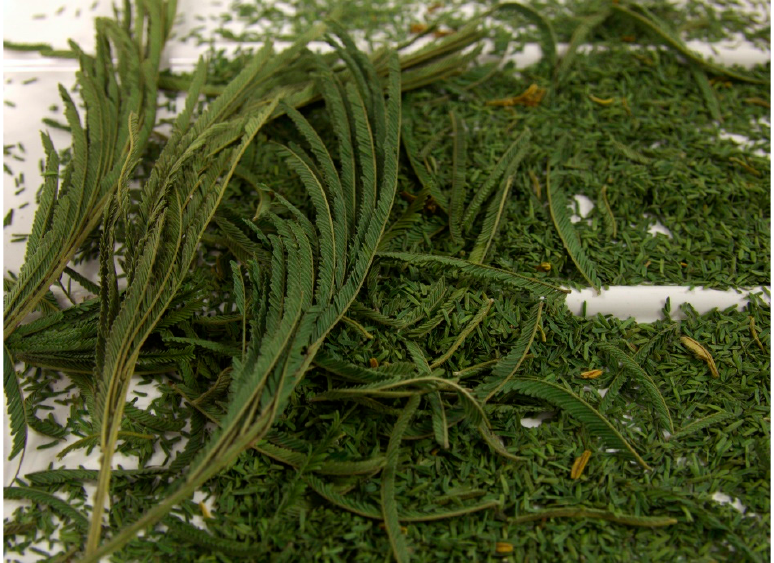
Figure 1. Oven-dried Acacia dealbata leaves.